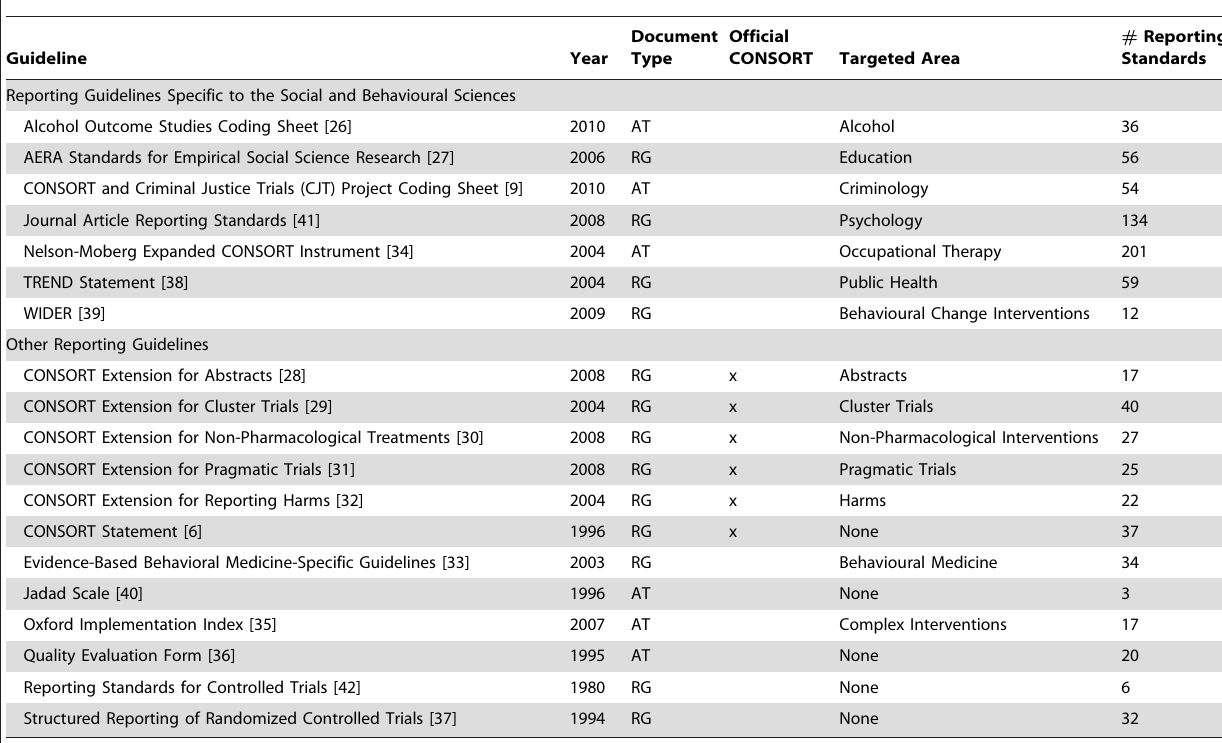
Table 1. Characteristics of included reporting guidelines and reporting quality assessment tools.